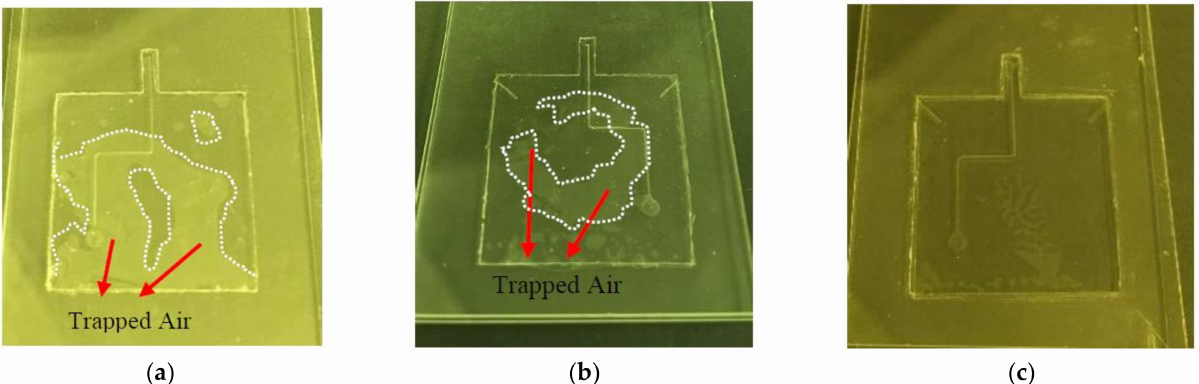
Figure 8. The effect of air-vent microchannel on tapped air-bubble size; ( a ) microchannel layer without air-vent channel; ( b ) microchannel layer with 300 µ m air-vent channel; ( c ) microchannel layer with 500 µ m air-vent